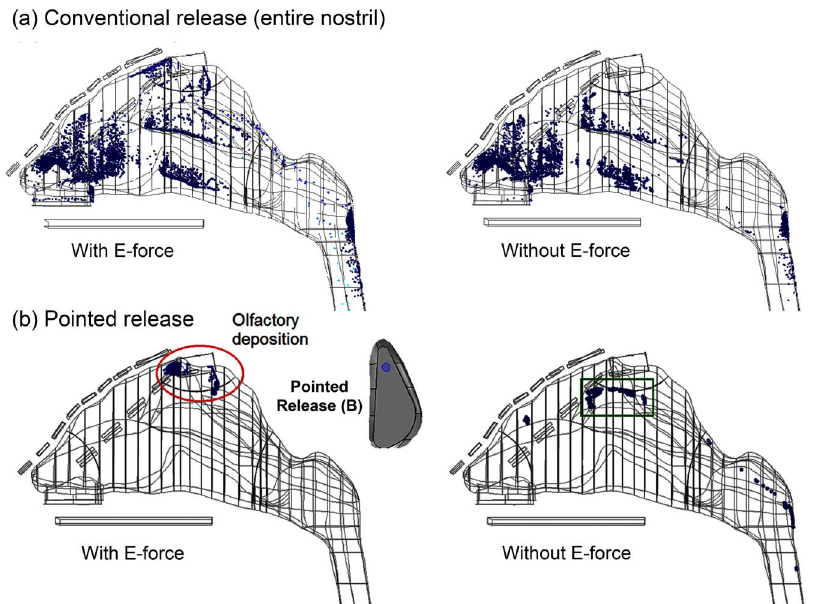
Figure 8. Comparison of deposition patterns with and without electrophoretic forces for particles released (a) over the entire area of the left nostril, and (b) at point B of the left nostril.